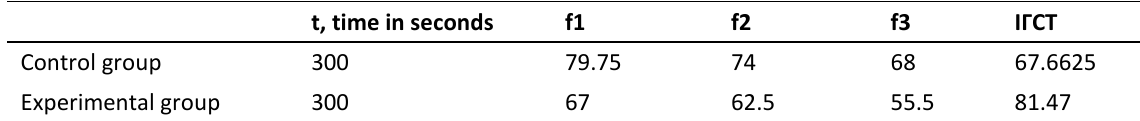
Table 7. Harvard step-test